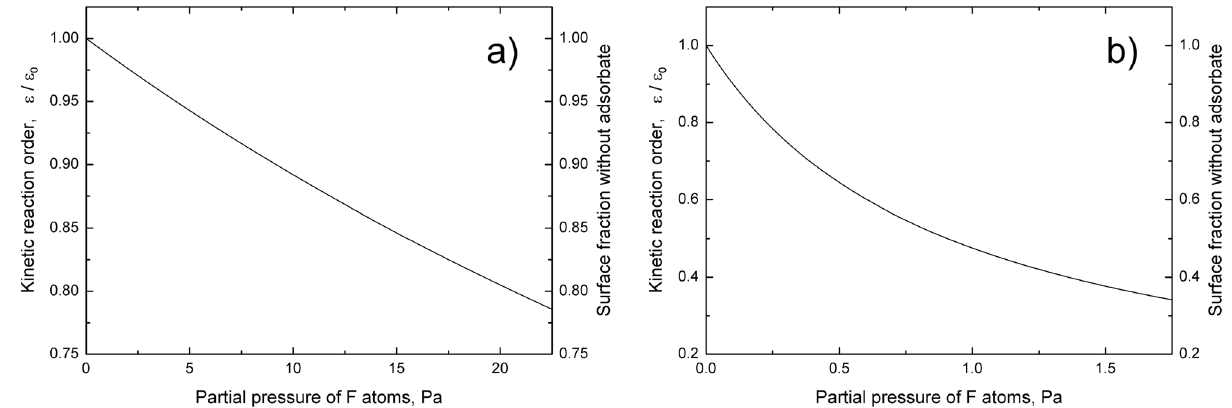
Figure 2. The theoretical dependences of kinetic reaction order, ratio ε/ε 0 , and surface area not covered with adsorbate on the partial pressure of F atoms: ( a ) experiment 17 , ( b ) experiment 18